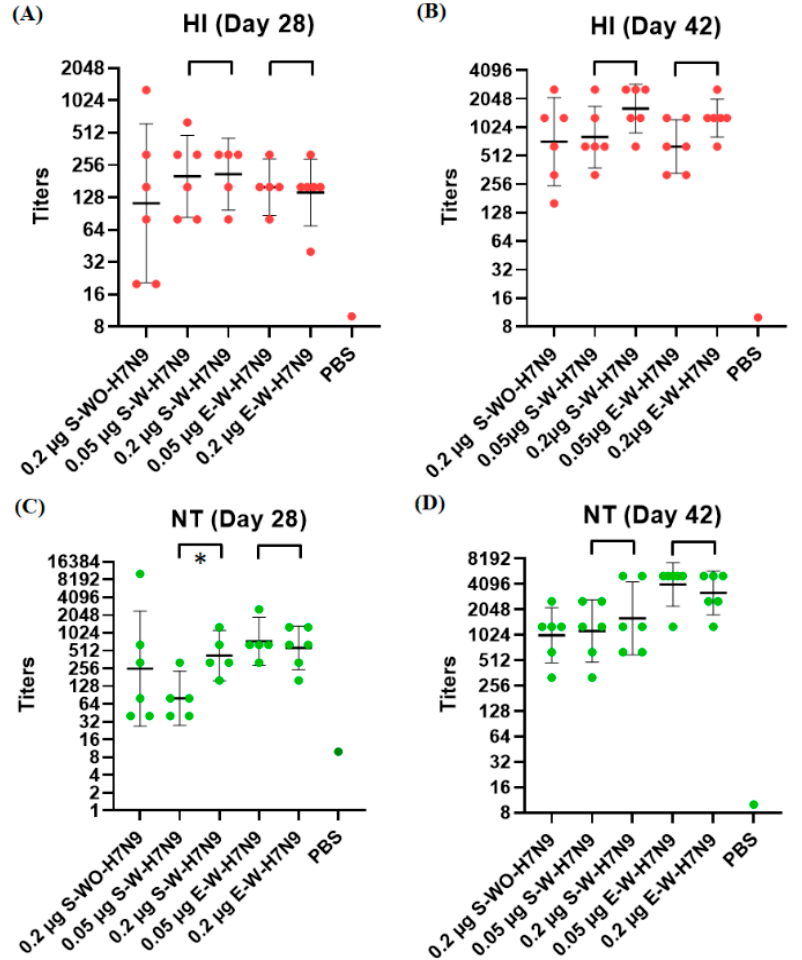
Figure 4. Serum HI and NT titers against H7N9 viruses in mice immunized with three H7N9 vaccine antigens. The sera were collected at 28 DPI (14 days post-dose-2) [( A , C )] and 42 DPI (14 days post-dose-3) [( B , D )] to measure the hemagglutination inhibition and neutralizing antibody titers and are expressed as the geometric mean ± 95 confidence interval. HI: hemagglutination inhibition; NT: neutralizing antibody. *: significant difference ( p < 0.05).